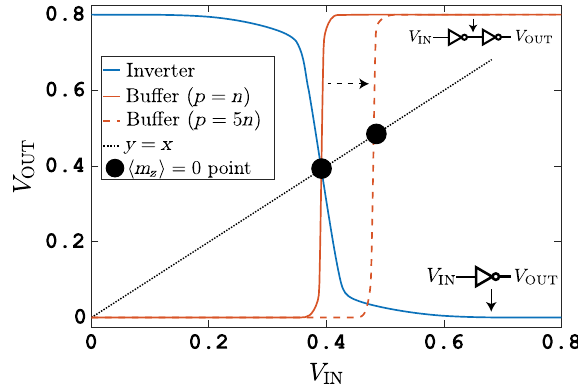
FIG. 5. 14-nm Predictive Technology Model, inverter or buffer. dc response of 14-nm HP FinFETs based on Ref. [44] for an inverter and buffer. Sizing the transistors differently allows the switching point to be shifted.